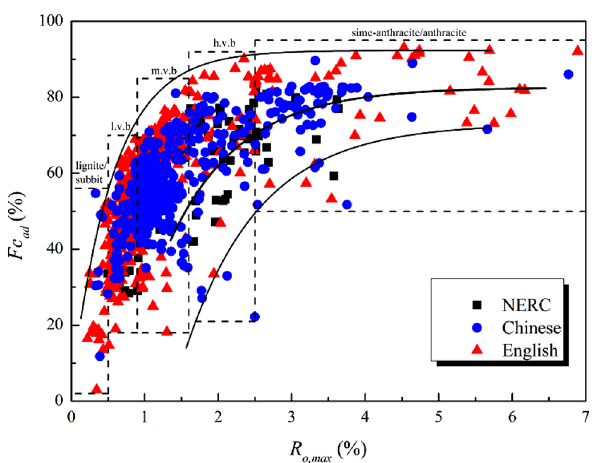
Fig. 8 Variation of Fc ad with vitrinite reflectance R o ; max . (Data size: NERC-189, Chinese (Yu et al. 2004; Chang et al. 2006; Qin et al. 2007; Chang et al. 2008; Hao et al. 2012; Zheng 2012; Jiang et al. 2012; Gao 2012; Li et al. 2013; Lin et al. 2013)-266, English (Mahajan and Walker 1971; Bhattacharyya 1972; Joubert et al.